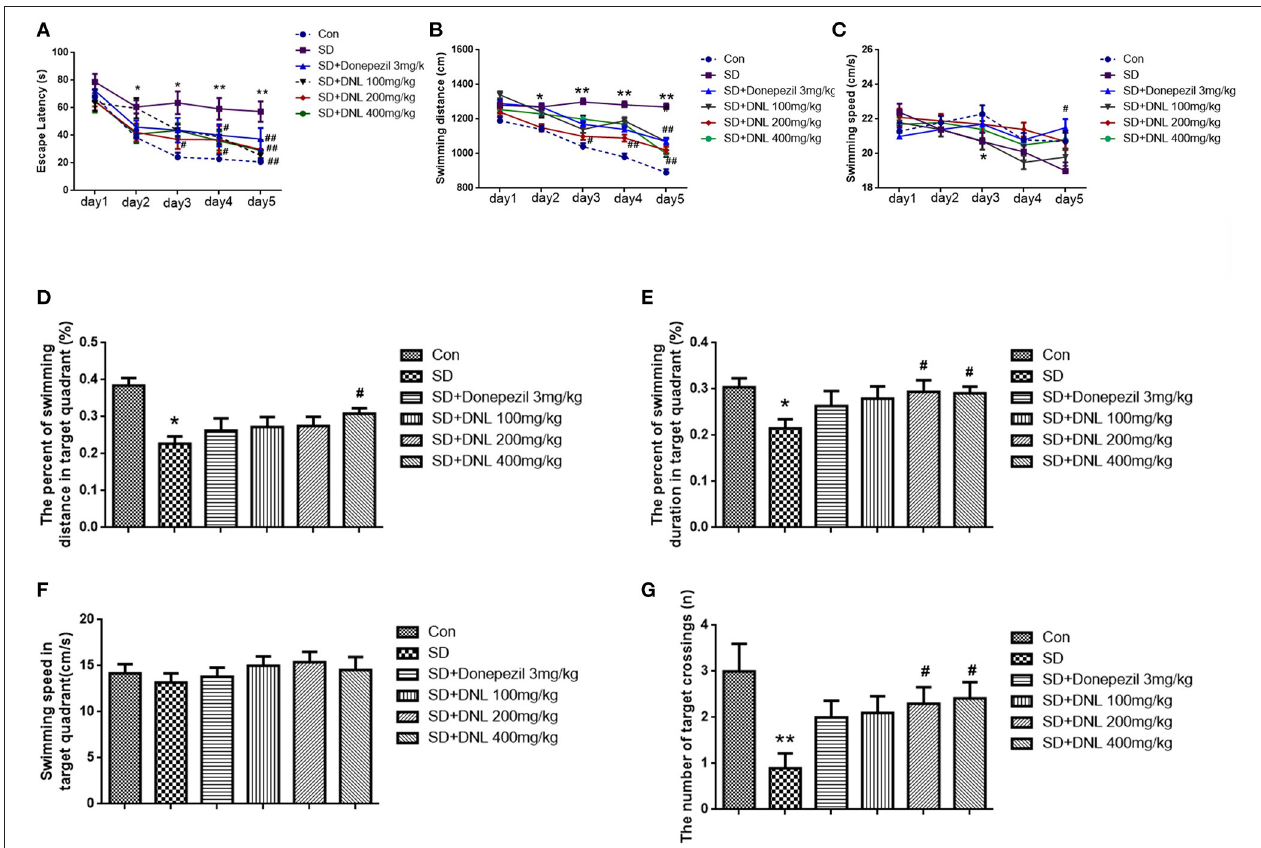
FIGURE 6 | The effect of DNL on the Escape Latency (A) ; Swimming distance (B) ; Swimming speed (C) ; The percent of swimming distance in target quadrant (D) ; The percent of swimming duration in target quadrant (E) ; Swimming speed in target quadrant (F) ; The number of target crossings (G) in the MWM test after SD 2 weeks in mice. Values are mean ± SEM, n = 10–12. * p < 0.05 vs. the Con group, ** p < 0.01 vs. the Con group; # p < 0.05 vs. the SD group, ## p < 0.01 vs. the SD group.